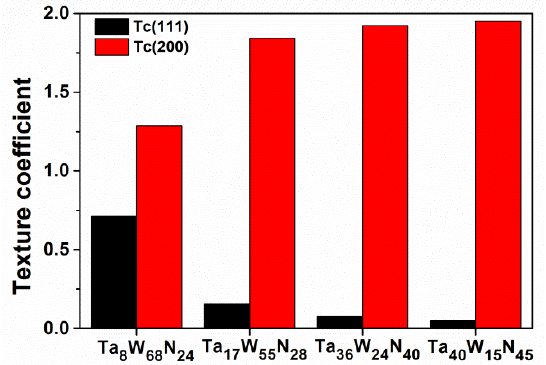
Figure 8. Texture coefficients of the TaWN films.